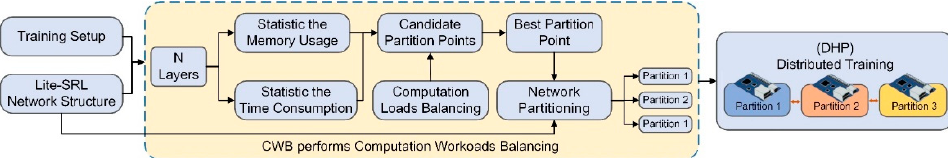
Figure 12. The flowchart of Lite-SRL’s deployment corresponds to the content in the following. N- Layers corresponds to Figure 13a; Statistic the Memory Usage corresponds to Figure 13b; Statistic the Time Consumption corresponds to Figure 13c; Candidate Partition Points corresponds to Figure 14a; Best Partition Point corresponds to Figure 14b.